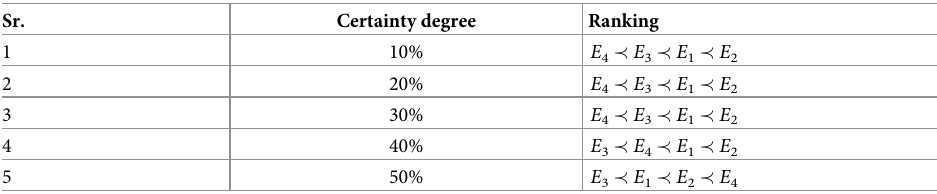
Table 4. EVaR results under PHF environment.